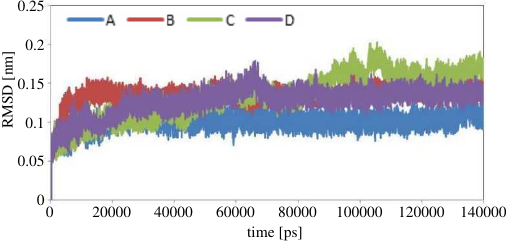
Figure 3: R g values (nm) versus time (ps) for simulated systems defined as A , B , C and D .